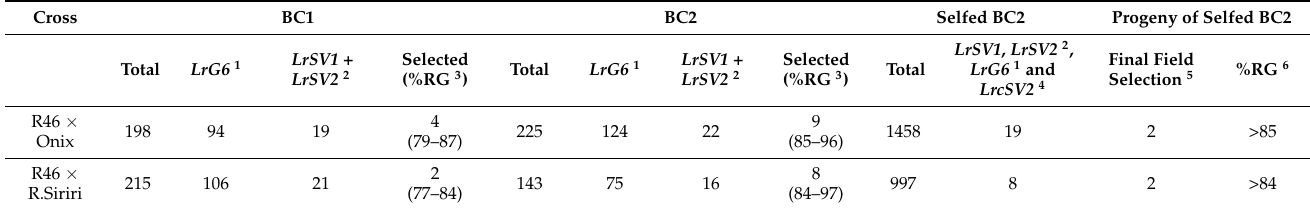
Table 6. Introgression into Onix and R.Siriri. Number of plants selected in each cycle. 1 Selected by seedling resistance to P. triticina race Ma07Bg9; 2 selected by their associated markers gwm261 and gwm533, respectively; 3 percentage of recurrent parent genome, calculated as described in Materials and Methods; 4 selected by its associated marker gwm149; 5 selected by rust resistance, phenotypic characteristics of height, plant architecture, stem thickness and spike size by comparison with the original commercial variety and homogeneity; 6 minimum %RG according to the BC2 %RG. Cross BC1 BC2